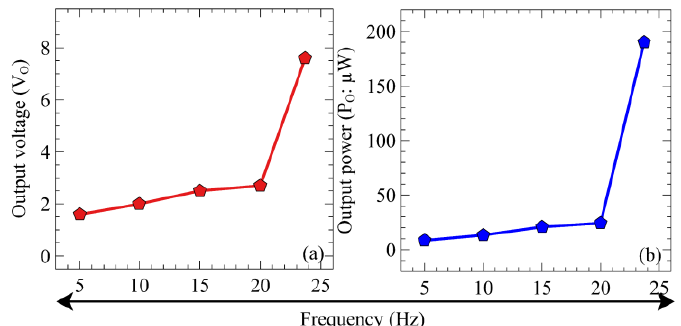
Figure 13. Outcomes of Test 1 at various frequencies. ( a ) Output voltage, ( b )output power.